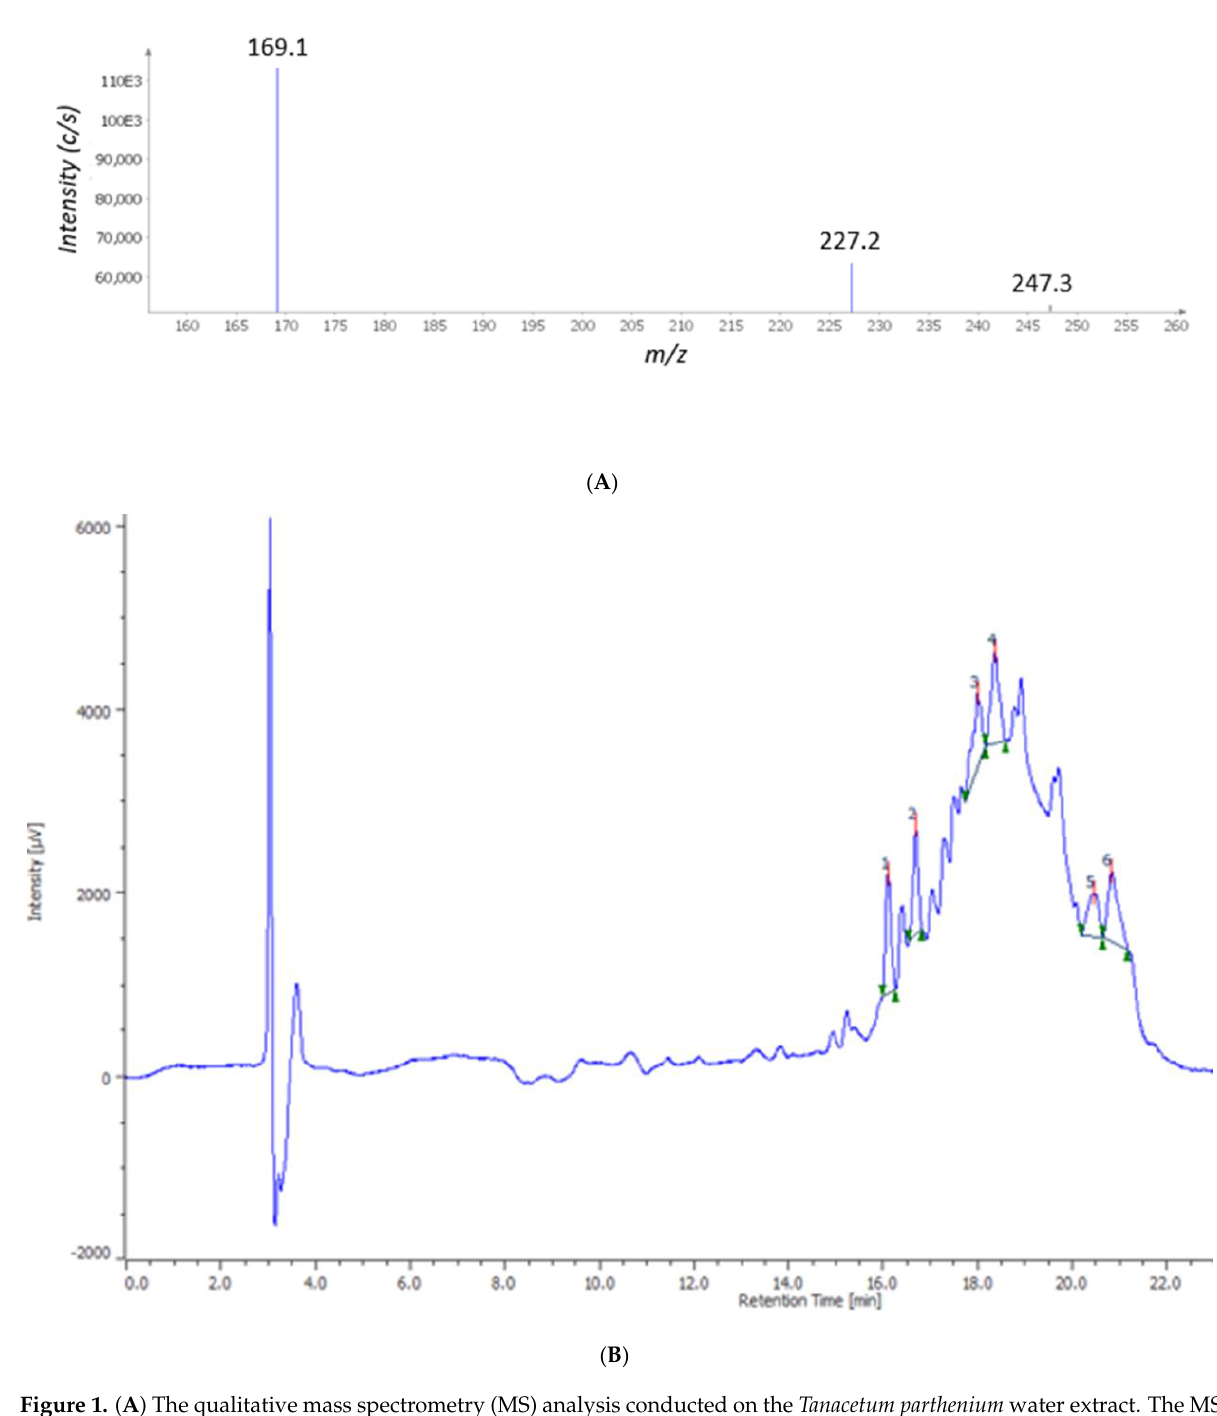
Figure 2. The targets–components analysis conducted via the STITCH platform (http://stitch.embl.de), highlighting the prominent role of cyclooxygenase-2 (COX-2/Ptgs2) in the components–targets plot.